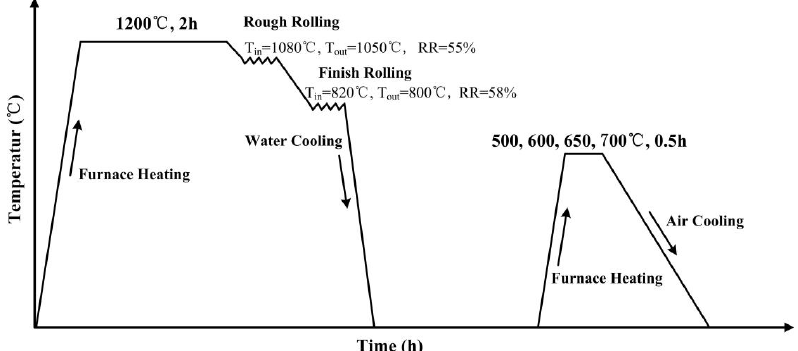
Figure 1. Schematic of the processing conditions of ultra-low carbon Cu-bearing steel.